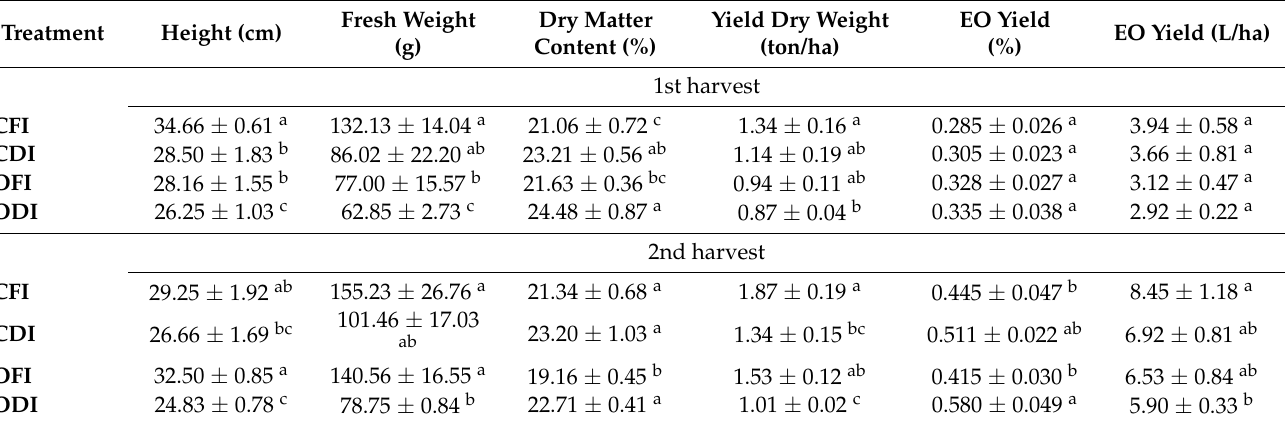
Table 1. Effect of cultivation (conventional-C or organic-O) and irrigation (full irrigation-FI or deficit irrigation-DI) practices on Mellissa plant growth and essential oil yields under two